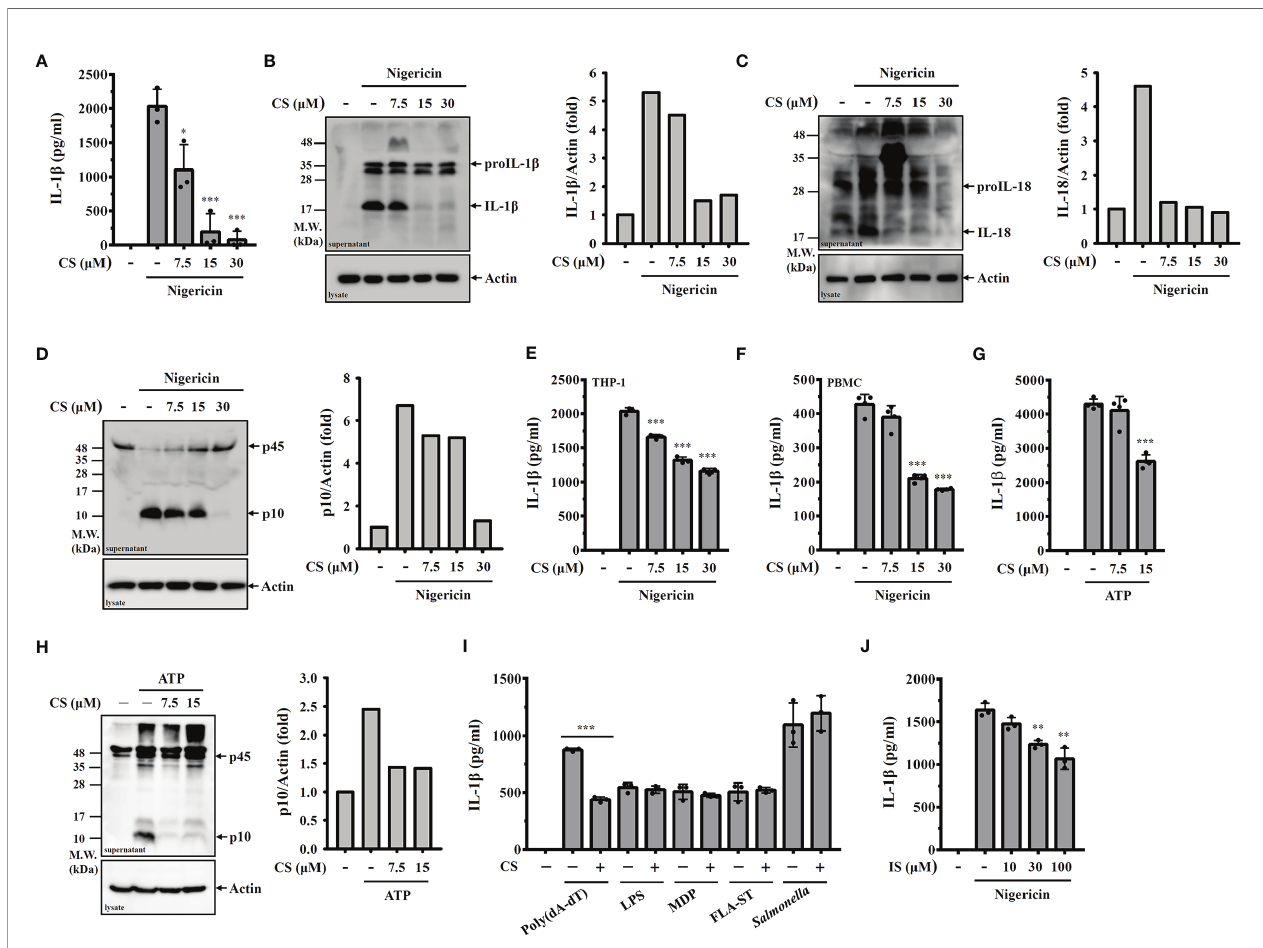
FIGURE 1 | CS inhibits NLRP3 in fl ammasome activation. (A – D) J774A.1 macrophages were primed with LPS for 5 h and incubated with CS for 0.5 h Cells were stimulated with 10 m M nigericin for 0.5 h The levels of IL-1 b in the supernatants were measured by ELISA (A) and Western blot (B) . The levels of IL-18 (C) and caspase-1 (D) in the supernatants were measured by Western blot. (E, F) Human THP-1 macrophages or PBMC were primed with LPS for 5 h and incubated with CS for 0.5 h Cells were stimulated with 10 m M nigericin for 0.5 h The levels of IL-1 b in the supernatants were measured by ELISA. (G, H) J774A.1 macrophages were primed with LPS for 5 h and incubated with CS for 0.5 h Cells were stimulated with 5 mM ATP for 0.5 h The levels of IL-1 b in the supernatants were measured by ELISA (G) and the levels of caspase-1 in the supernatants were measured by Western blot (H) . (I) J774A.1 macrophages were primed with LPS or Pam3CSK4 (for non-canonical in fl ammasome) for 5 h and incubated with CS for 0.5 h Cells were transfected with poly(dA/dT), LPS, MDP or FLA-ST for 6 h or infected with Salmonella for 2 h The levels of IL-1 b in the supernatants were measured by ELISA. (J) J774A.1 macrophages were primed with LPS for 5 h and incubated